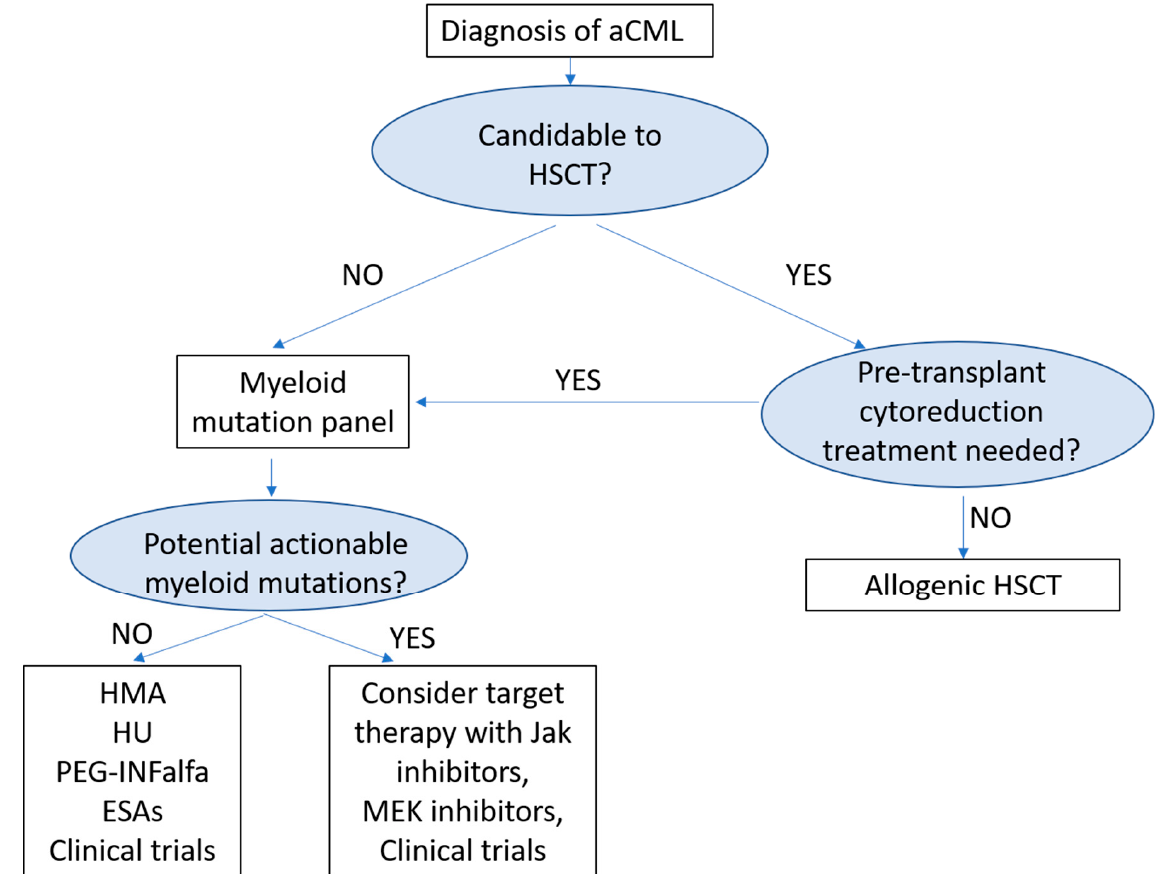
Figure 1. Treatment Algorithm for Atypical Chronic Myeloid Leukemia (aCML). HSCT: Hematopoietic Stem Cell Transplantation; HMA: hypomethylating agents; HU: Hydroxyurea; PEG- INFalfa: pegylated interferon-alfa; and ESAs: erythropoiesis stimulating agents.